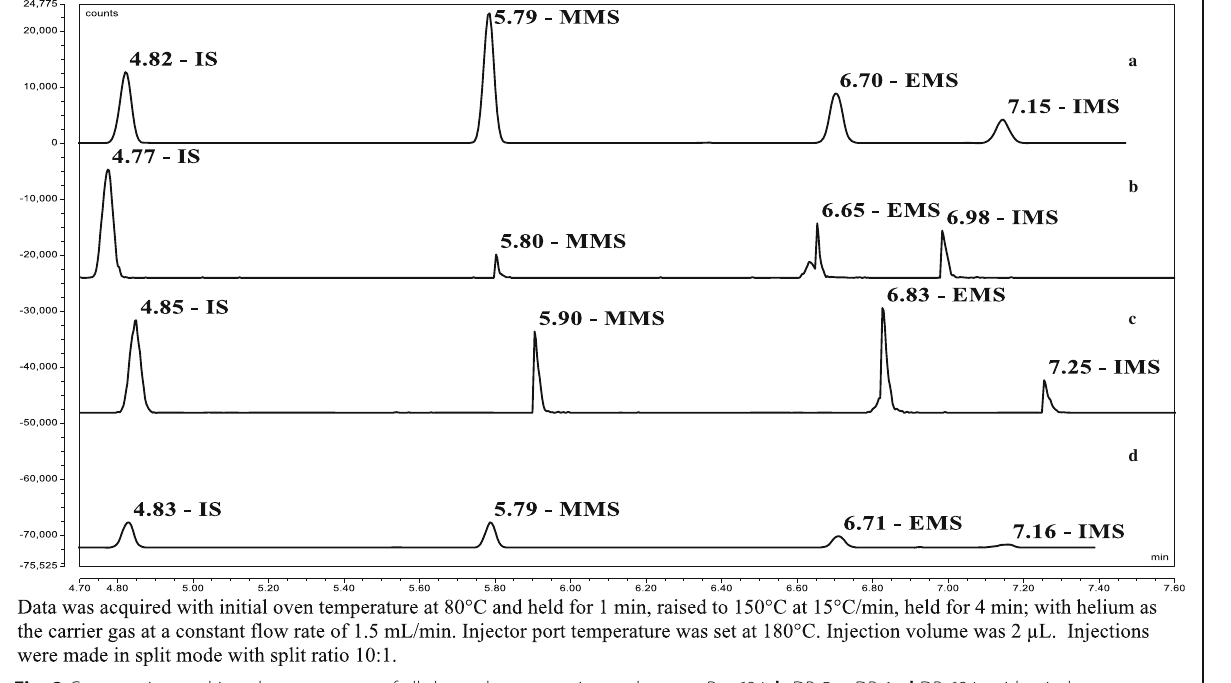
Fig. 2 Comparative total ion chromatograms of alkyl mesylates on various columns a Rtx-624, b DB-5, c DB-1, d DB-624 at identical GC conditions